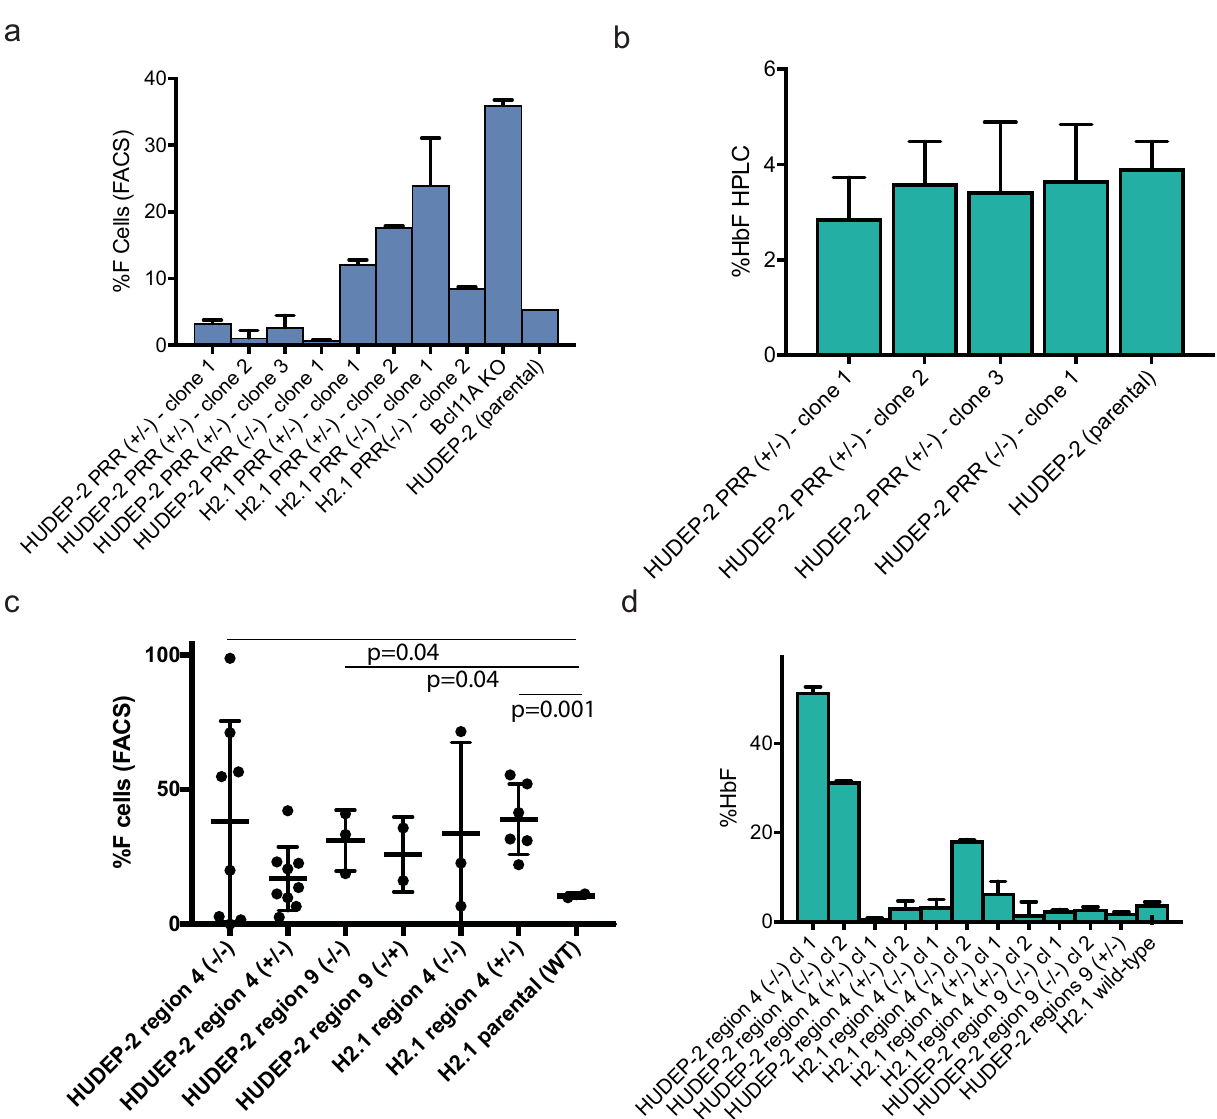
Fig 3. Interrogation of HUDEP-2 and H2.1 cell clones carrying deletions of the PRR and selected sub-regions. A) Proportion of HbF-expressing cells assayed by flow cytometry in cell clones carrying the indicated PRR deletions (mean ± s.d. of 3 biological replicates). B) Quantitation of HbF expression by HPLC in selected clones carrying the indicated PRR deletions, (mean ± s.d. of 3 technical replicates). No significant differences in HbF expression were seen in comparison to parent HUDEP-2 cells. C) Expression of HbF in clonal cell lines carrying the indicated sub-region deletions, measured by flow cytometry, error bars represent mean ± s.d. of 2–8 independently-derived clones for each genotype. Clones with statistically significant differences in HbF-expressing cells compared to unedited H2.1 cells are noted (unpaired t-test). D) Expression of HbF in selected clonal cell lines carrying the indicated sub-region deletions, measured by hemoglobin HPLC Each bar represents the mean ± s.d. of 3 technical replicates for each clone. Phenotypic information for each clone is in Table a in S1 File.